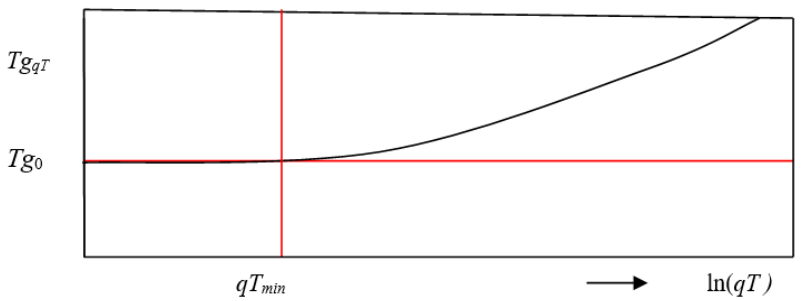
Figure 9. Tg = f( qT )) (schematic).